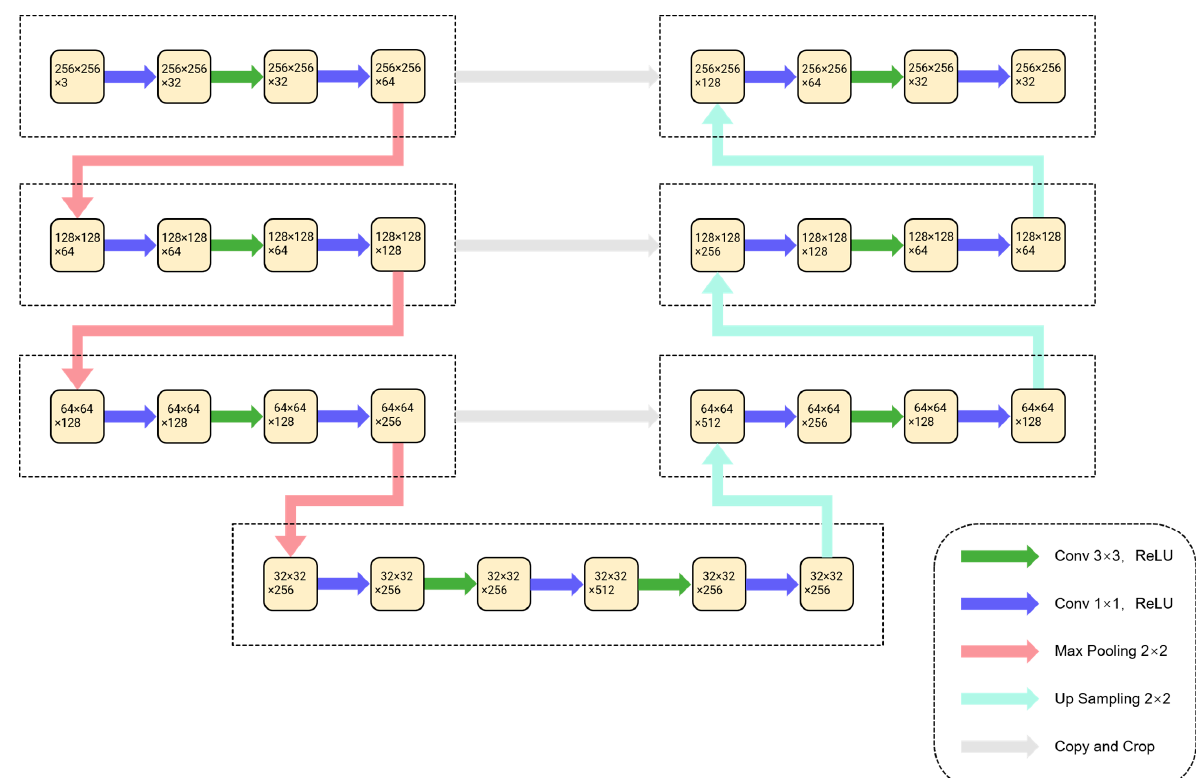
Figure 1. Overall framework of BU-Net.